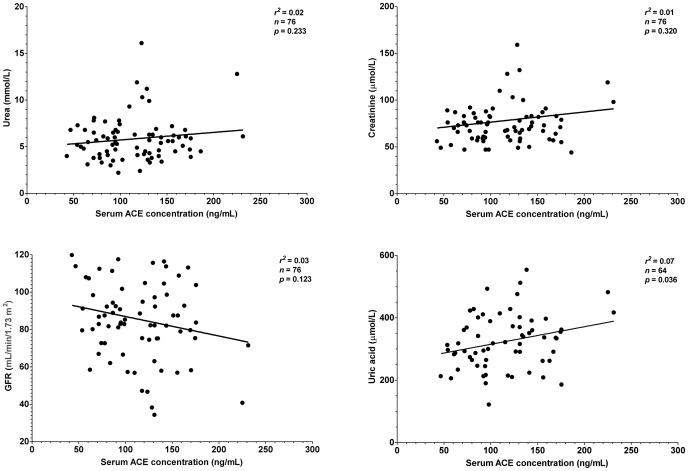
There is no relationship between parameters of renal function and serum ACE concentration.Renal function was assessed by the means of urea, creatinine and uric acid concentrations in the sera and by the glomerular filtration rate (GFR) values. Values were plotted as a function of the serum ACE concentration (n = 151 patients). Points were fitted by a linear regression to reveal the potential correlation between the plotted parameters. Parameters of the fitting are shown in each graph. Normal ranges for the values are: urea, 3.6–7.2 mmol/L, creatinine, 44–97 µmol/L (female) and 62–106 µmol/L (male), GFR, above 90 mL/min/1.73 m2, uric acid, 140–340 µmol/L (female) and 220–420 µmol/L (male).